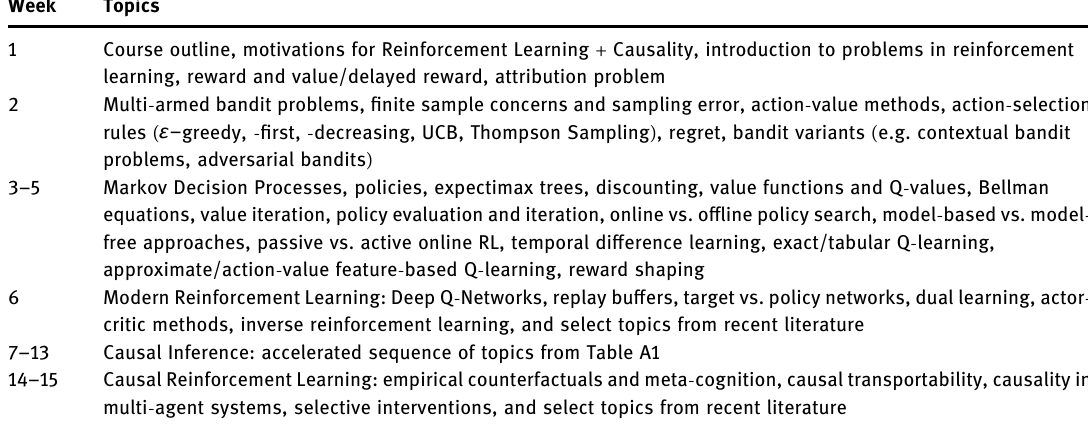
Table A2: Outline of topics in sample undergraduate treatment of causal inference paired with reinforcement learning Week